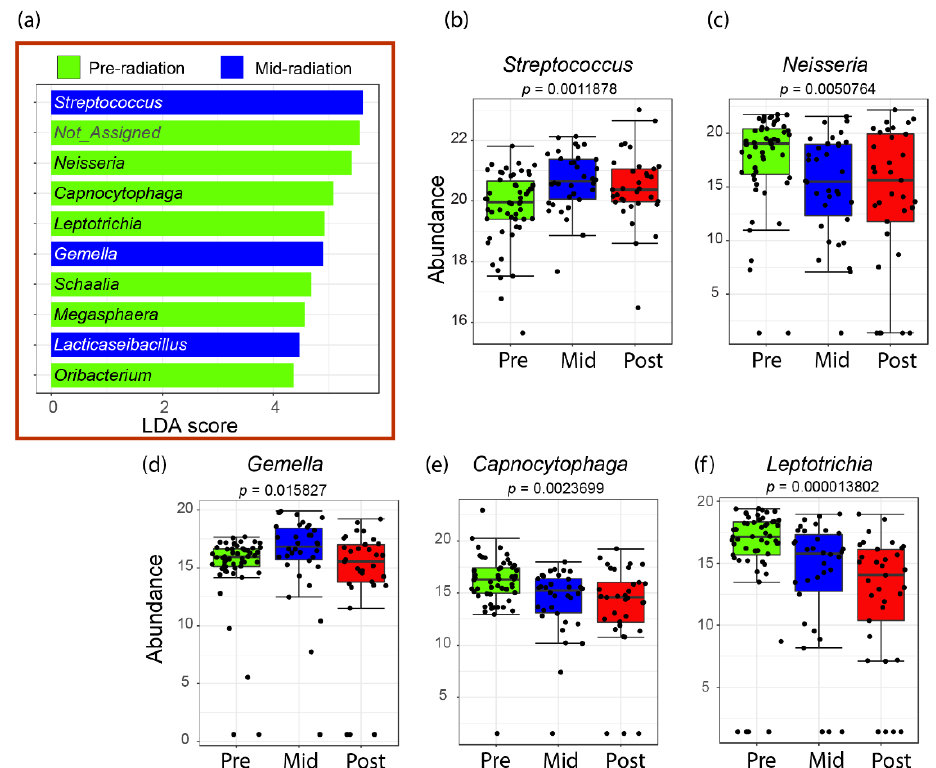
Figure 6. Bacterial genera with increased relative abundance before or after radiotherapy plotted in a LEfSe. The plot bars inside the red box ( a ) correspond to the overall taxa that are significantly abundant either in pre-RT or mid-RT samples. No significant taxa were specified to the post-RT groups since no differences in β -diversity were observed between mid and one-month post-radiation. The not assigned bar corresponds to the family Pasteurellaceae , of which no specific genus could be identified. Data point visualization is shown here for the top five identified genera, including the mid-RT biomarkers, namely Streptococcus ( b ), Gemella ( d ) and the top pre-RT taxa Neisseria ( c ), Capnocytophaga ( e ) and Leptotrichia ( f ).